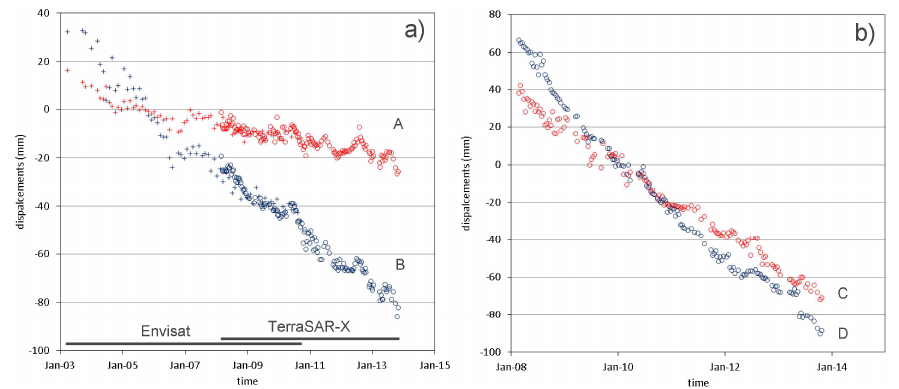
Figure 7. Examples of displacement history in the LOS direction for four PTs (A-D), at the Malamocco inlet (see positions in Figure 6b): ( a ) ENVISAT PSI between April 2003 and November 2007 and TerraSAR-X between March 2008 and November 2013 (A and B); and ( b ) TerraSAR-X PSI between March 2008 and November 2013 (C and